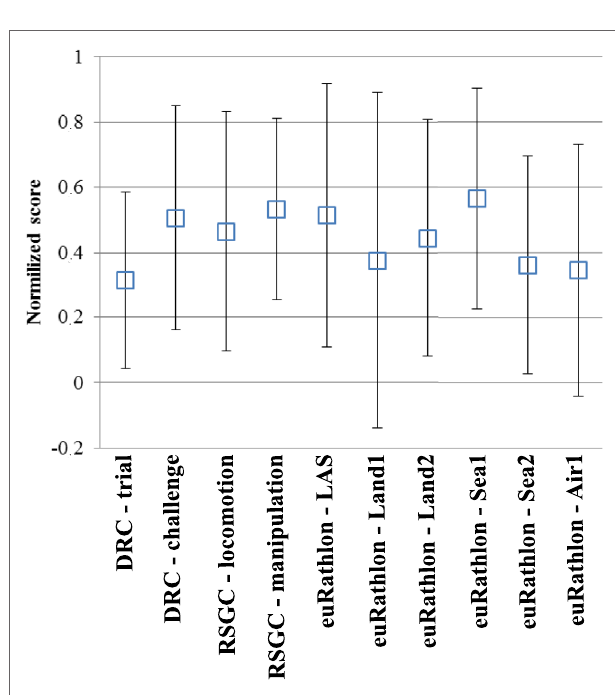
FIGURe 8 | Comparison among task-oriented challenge results (normalized with respect to the maximum score being achieved) . All results are included between 0.3 and 0.6, with the majority of them between 0.4 and 0.6.